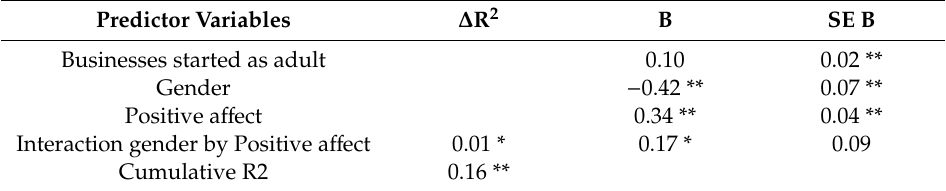
Table 3. Results of regression predicting EINT based on gender and positive a ff ect. Predictor